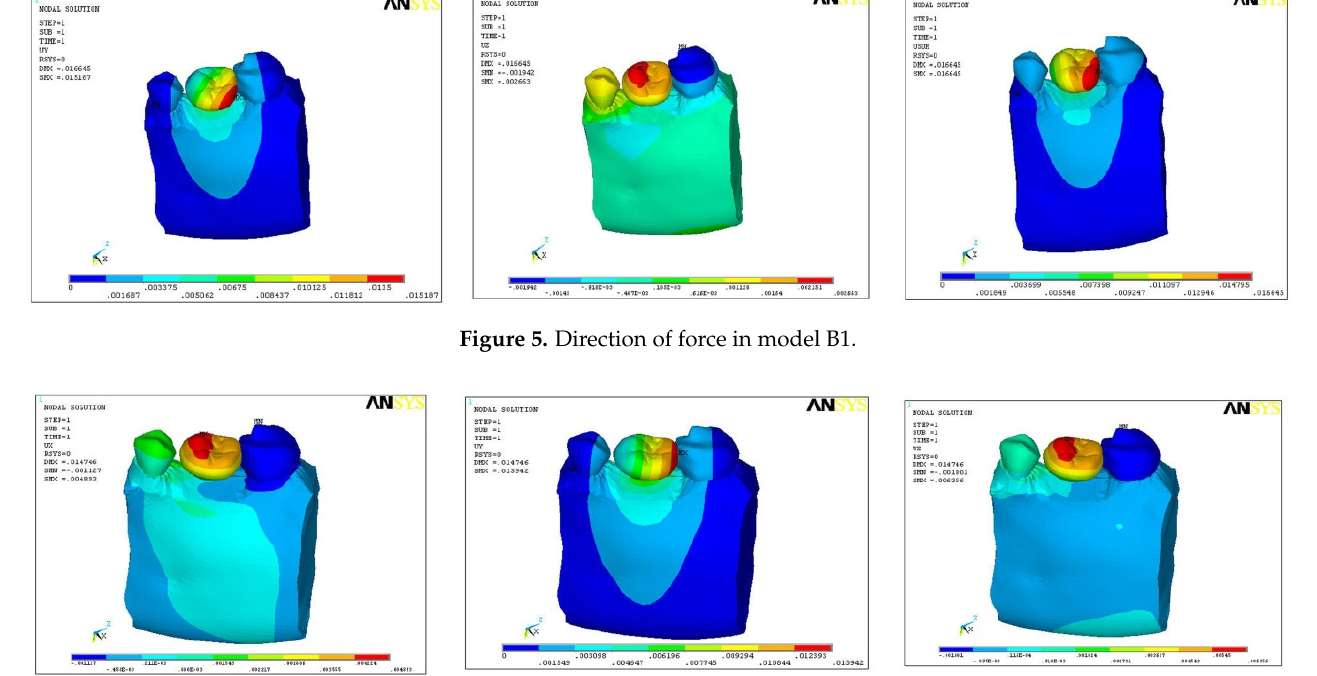
Figure 6. Direction of force in model B2.